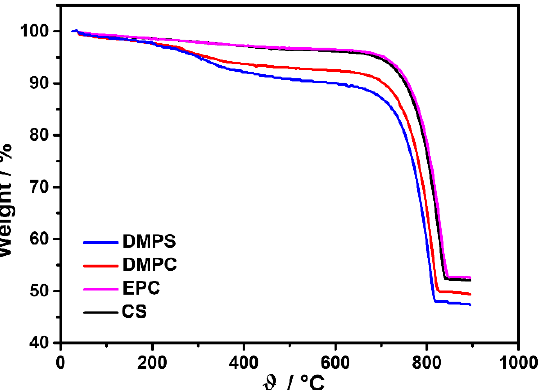
Figure 8. Thermogravimetric analysis of sample formed after 10 min of aging time in the absence (CS) and presence of different liposomes. c i (Ca) = c i (CO 3 ), γ (lipid) = 25.0 ppm, pH i = 8.15, ϑ /°C = 25 ± 0.1.